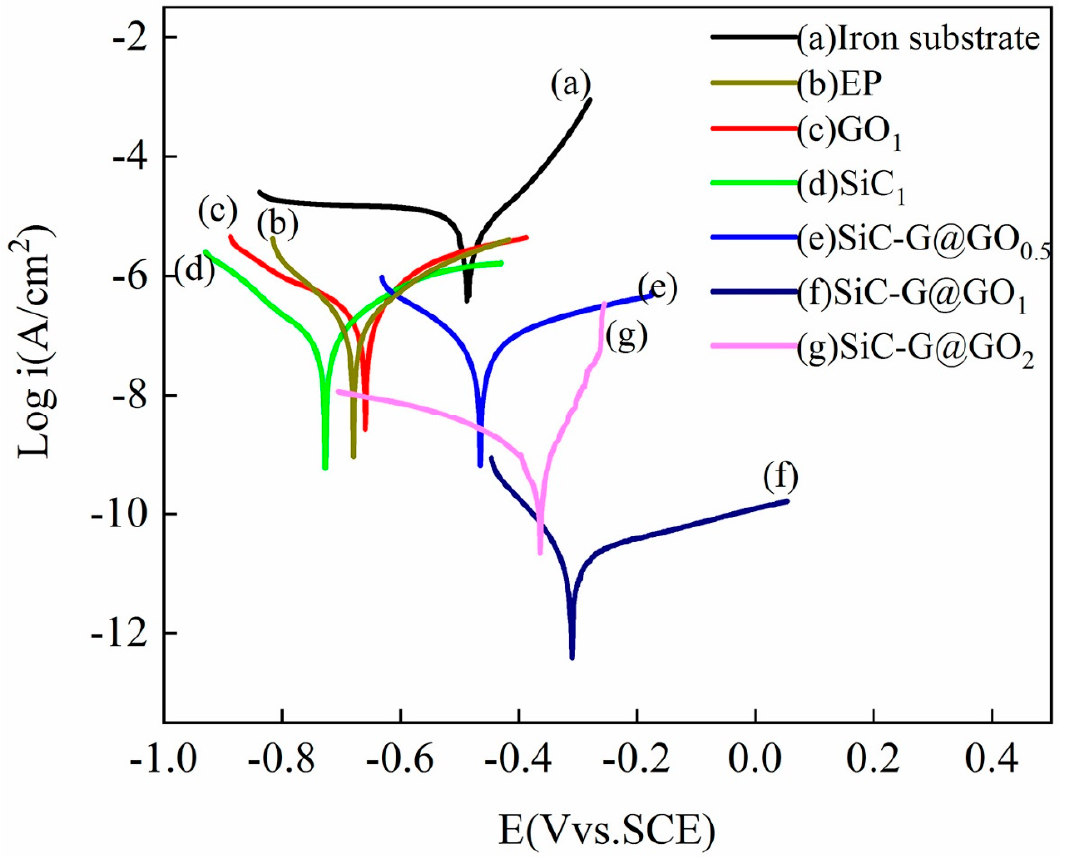
Figure 14. Polarization curves of the coated samples. Table 4. The electrochemical corrosion parameters derived from the potentiodynamic polarization test.